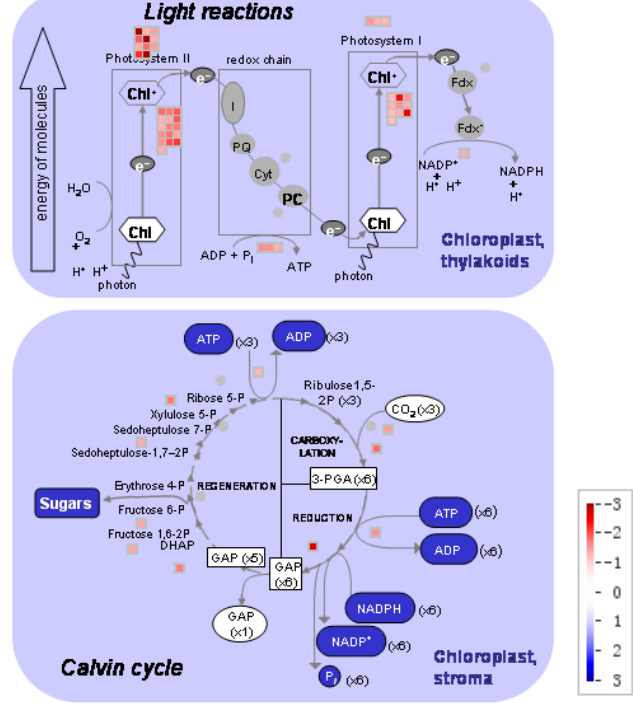
Figure 5. The distribution of different gene expressions related to photosynthesis in the maize leaf (low nitrogen versus high nitrogen). High nitrogen: 4 mM Ca(NO 3 ) 2 ; Low nitrogen: 40 µM Ca(NO 3 ) 2 .